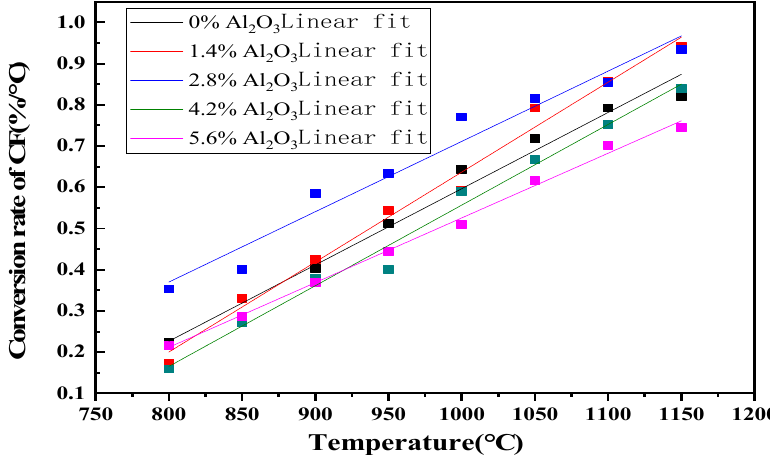
Figure 10. Comparison of samples with di ff erent Al 2 O 3 concentrations on the conversion rate of CF at di ff erent temperatures.